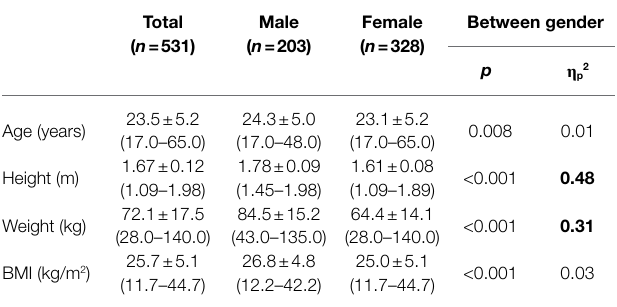
TABLE 1 | Demographic and anthropometric characteristics of all participants ( n =